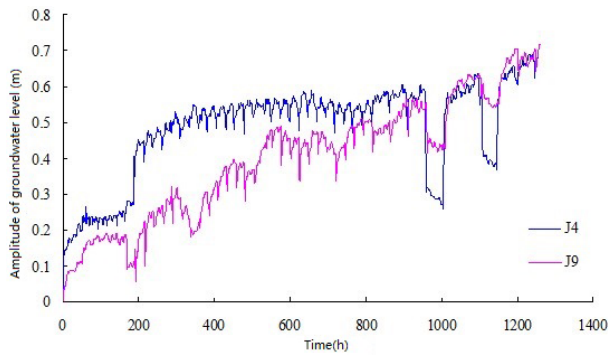
Figure 4. Groundwater lever curve of J4 and J9 during